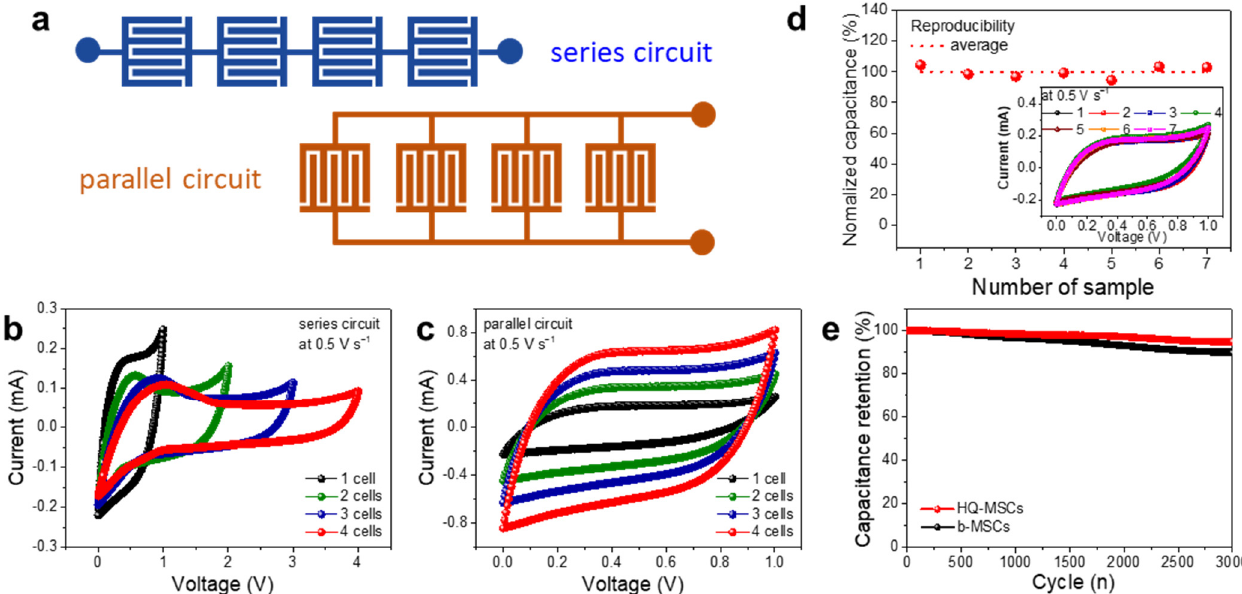
Figure 5. ( a ) Schematic illustration of series and parallel circuits for HQ-MSCs. CV curves of HQ-MSCs connected in ( b ) series and ( c ) parallel circuits. ( d ) Reproducibility and ( e ) cyclability tests of HQ-MSCs (the inset of Figure 5d indicates CV curves obtained for seven HQ-MSCs devices).